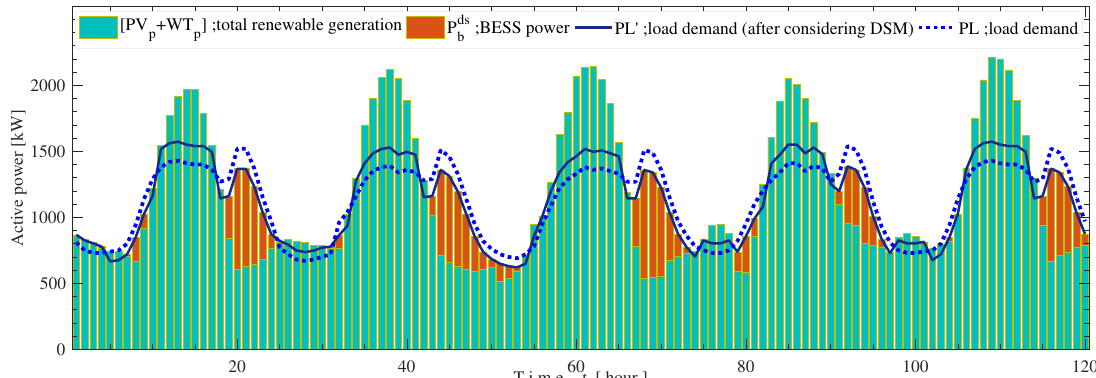
Figure 9. Aggregated power generated, BESS discharging power and load demand profiles with DSM strategy inclusion (case 2).